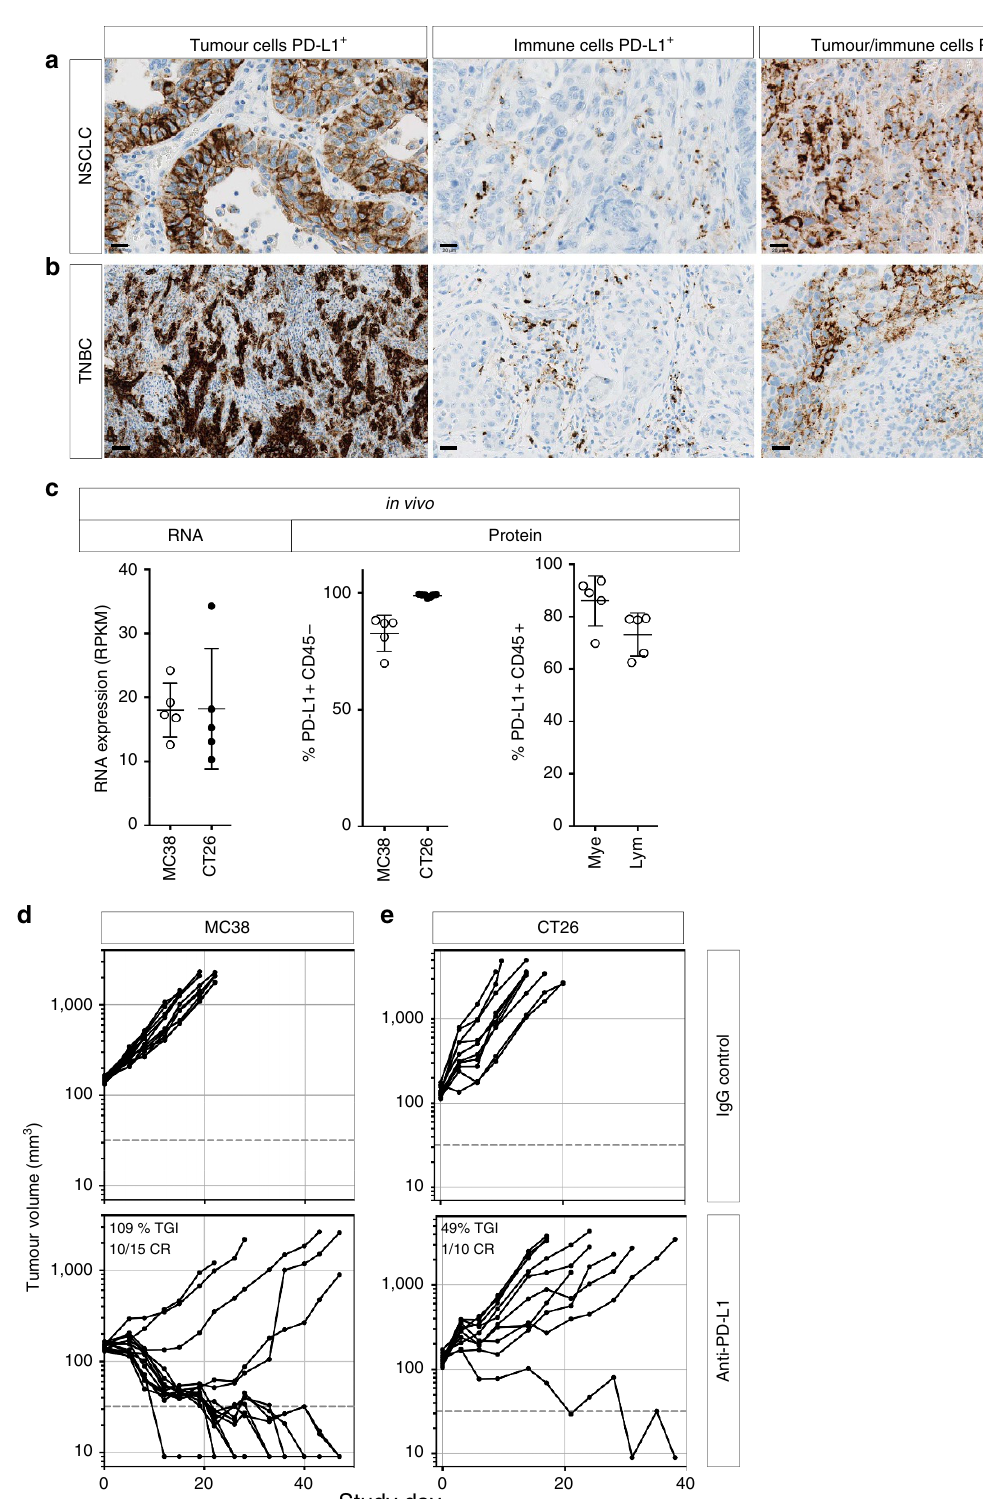
Figure 1 | PD-L1 expression in malignant epithelial and immune cells of human tumours. IHC analysis of human non-small-cell lung cancer (NSCLC) ( a ) and triple-negative breast cancer (TNBC) ( b ) samples identified three distinct patterns of PD-L1 expression (brown) in the tumour epithelium, immune cells or both compartments. In mouse tumour models in vivo , PD-L1 RNA and surface protein expression were detectable in MC-38 or CT-26 tumour cells, as well as in myeloid (mye) and lymphoid (lym) cells ( c ). Treatment of wild-type MC-38 ( d ) or CT-26 ( e ) tumours with anti-PD-L1 blocking antibodies resulted in slowed tumour growth and tumour regressions. If not labelled in graph, data shown is from MC38 (open circles) and CT26 (filled circles). Treatment data is representative of multiple independent study repeats with the same antibody. CR, complete regression; TGI, tumour growth inhibition. Scale bar represents 20 m m. Error bars depict s.d. from the mean.